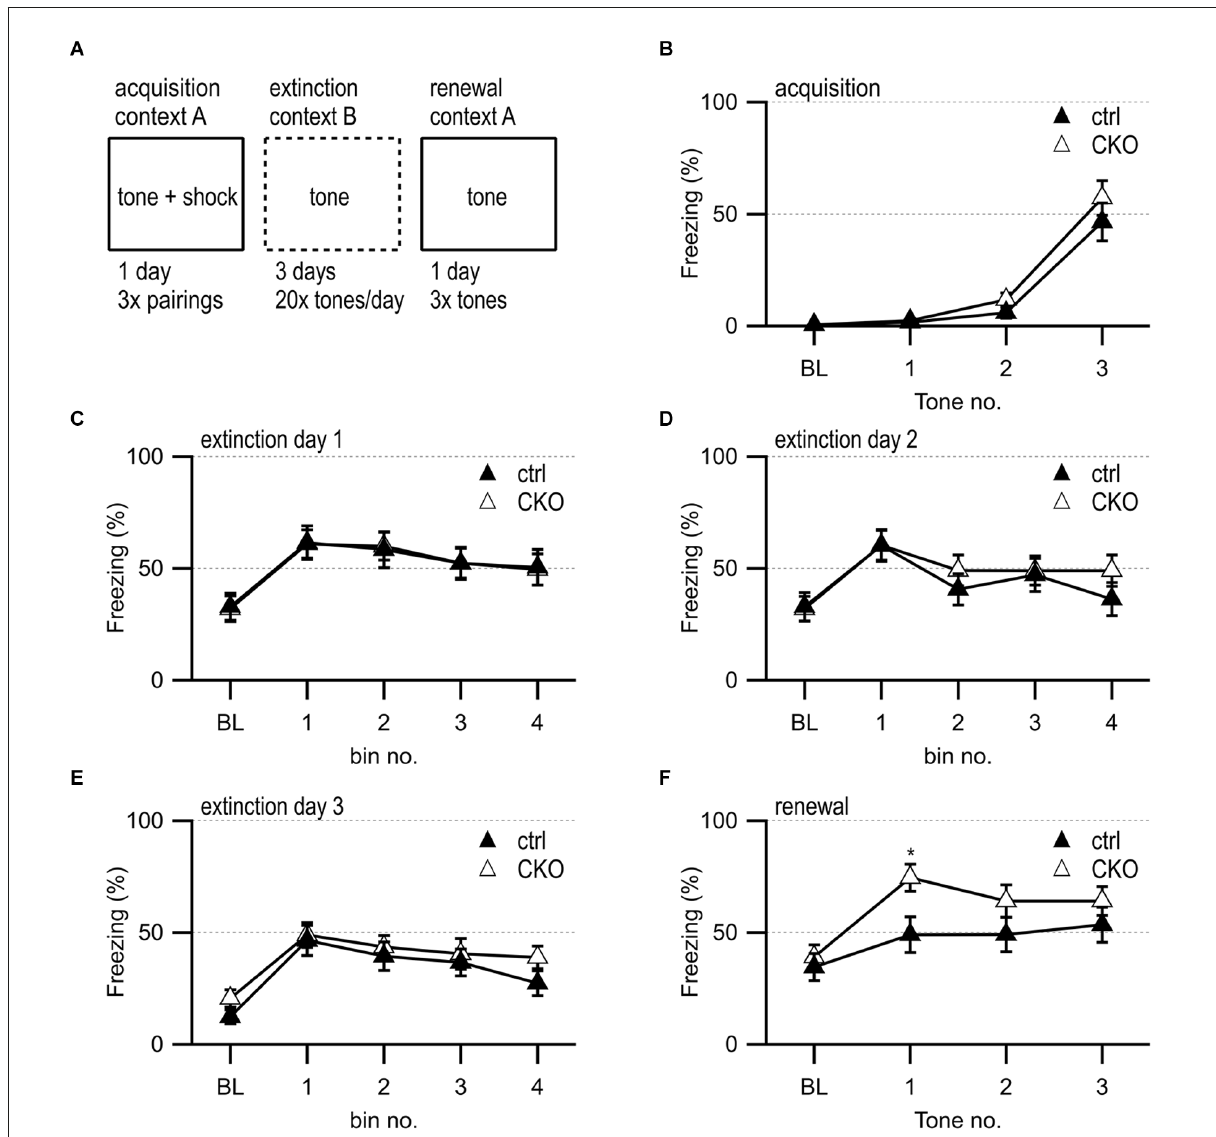
FIGURE5 Loss of GABA co-transmission from ACh neurons leads to transient increased freezing during contextual fear renewal. (A) Timeline of fear conditioning experiment. Acquisition of fear memory on day 1 by 3 × pairing of 75 dB 2,800 Hz pure tone with 2 s 0.5 mV foot shock in context A. During 3 days of extinction, animal was presented with 20 tones/day in context B. During the renewal of the fear memory, animal was presented with three tones in context A. (B) Percent of freezing during acquisition phase at baseline (BL) and per tone/foot shock pairing. (C–E) Percent of freezing during extinction phase at baseline (BL) and per five tone bin on day 1 (C) , day 2 (D) , and day 3 (E) . (F) Percent of freezing during renewal phase at baseline (BL) and per tone presentation. Values represent mean ± SEM. Two-way ANOVA followed by Fisher’s protected least-significant difference test (* p < 0.05). See Supplementary Table 6 for